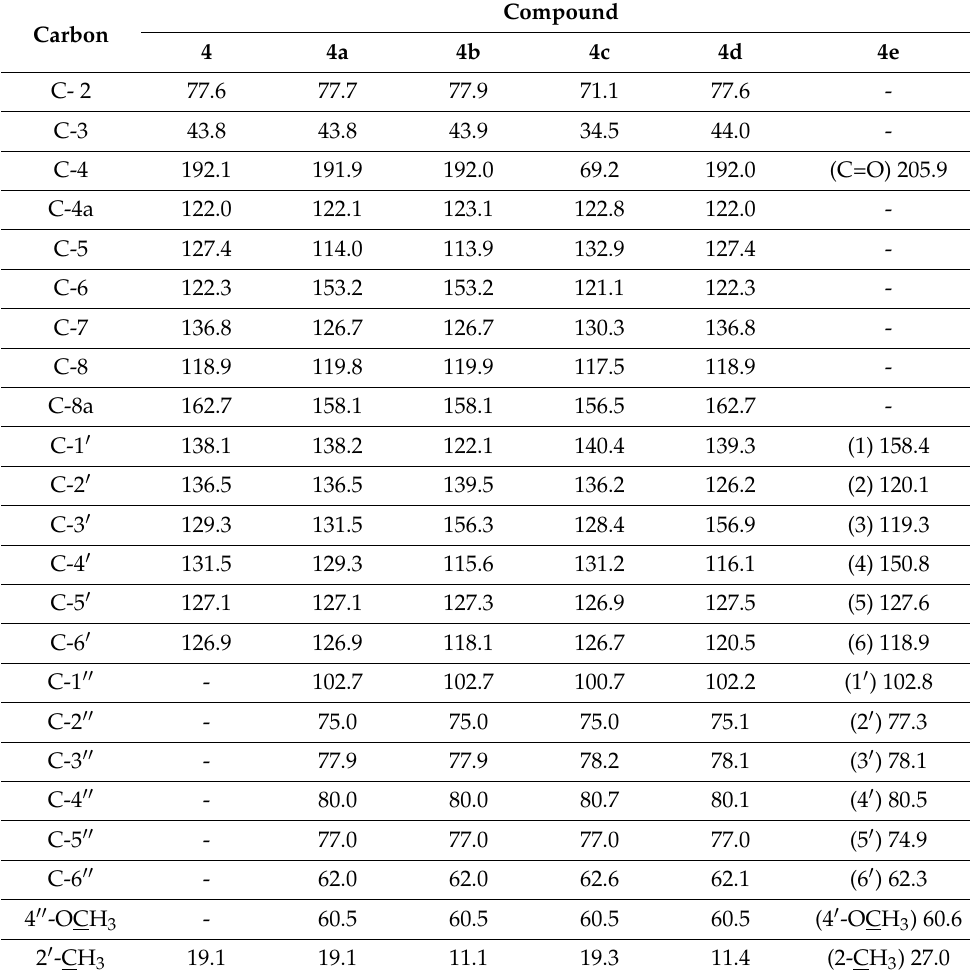
Table 2. 13 C-NMR chemical shifts δ (ppm) and coupling constants J (Hz) of 2 (cid:48) -methylflavanone ( 4 ) and products of its biotransformations 4a – 4e in Acetone-d6, 151 MHz (Supplementary Materials: Figures S5, S21, S41, S57, S75,